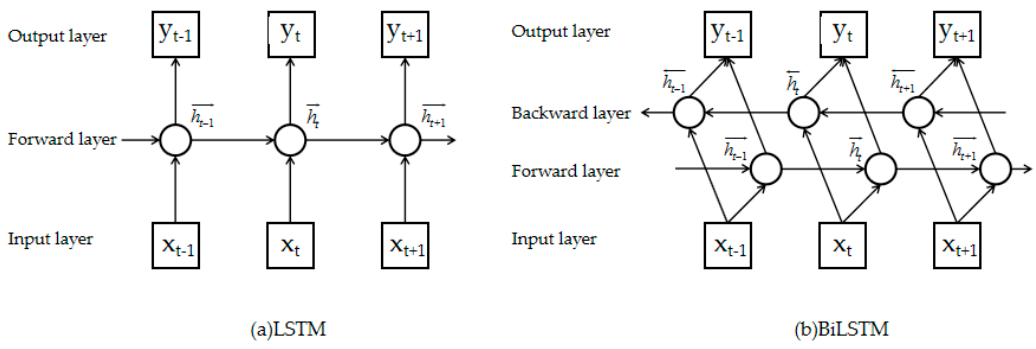
Figure 4. The architecture of the ( a ) LSTM model and ( b ) BiLSTM model.